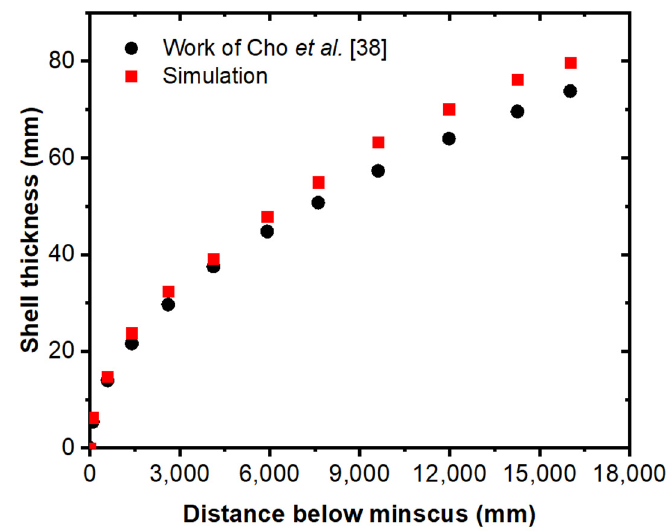
Figure 4. Comparison of solidifying steel shell thickness in the mold (Cho et al. [38]).